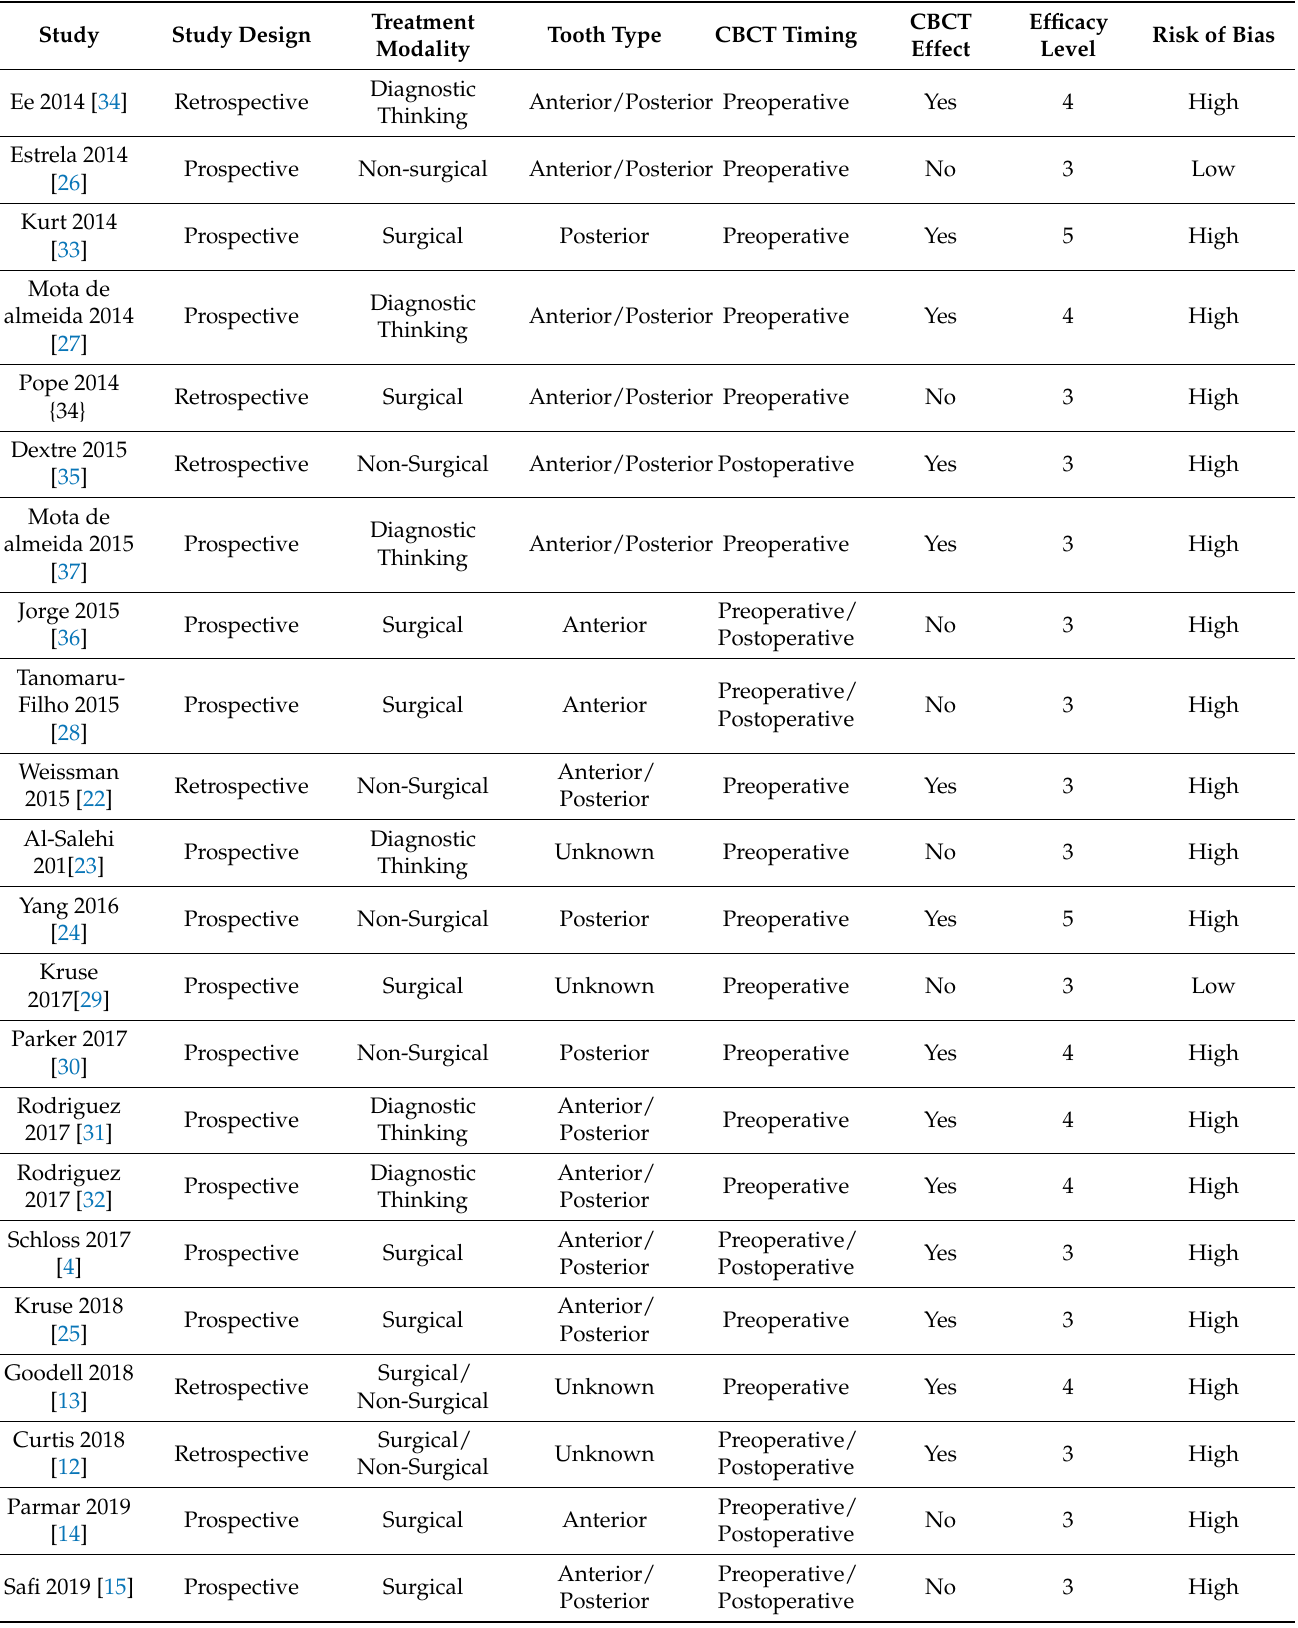
Table 2. The characteristics of the included